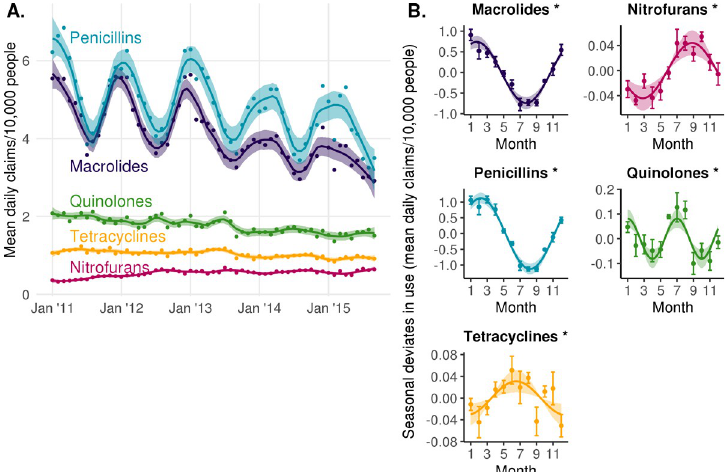
Fig 1. Seasonal patterns of antibiotic use by class. (A) Average daily antibiotic claims per 10,000 people by calendar month in Boston, Massachusetts from 2011 to 2015. Lines indicate LOESS smoothing curves and shaded regions indicate 95% CIs. (B) Sinusoidal model fits for monthly prescribing rate. Points indicate monthly mean seasonal deviates in average daily antibiotic claims per 10,000 people by calendar month and error bars indicate the standard error of the mean. Lines indicate the point estimate for the amplitude and phase of the sinusoidal model. Shaded regions indicate the 95% CIs for the amplitude. Asterisks indicate the amplitude of seasonality is statistically significant (FDR < 0.05). F AU : AbbreviationlistshavebeencompiledforthoseusedthroughoutFigs 1 (cid:0) 4 : Pleaseverifythatallentriesarecorrect : DR, false discovery rate. Underlying data are available at https://github.com/gradlab/use-resistance- seasonality/tree/master/figure_data/Fig1